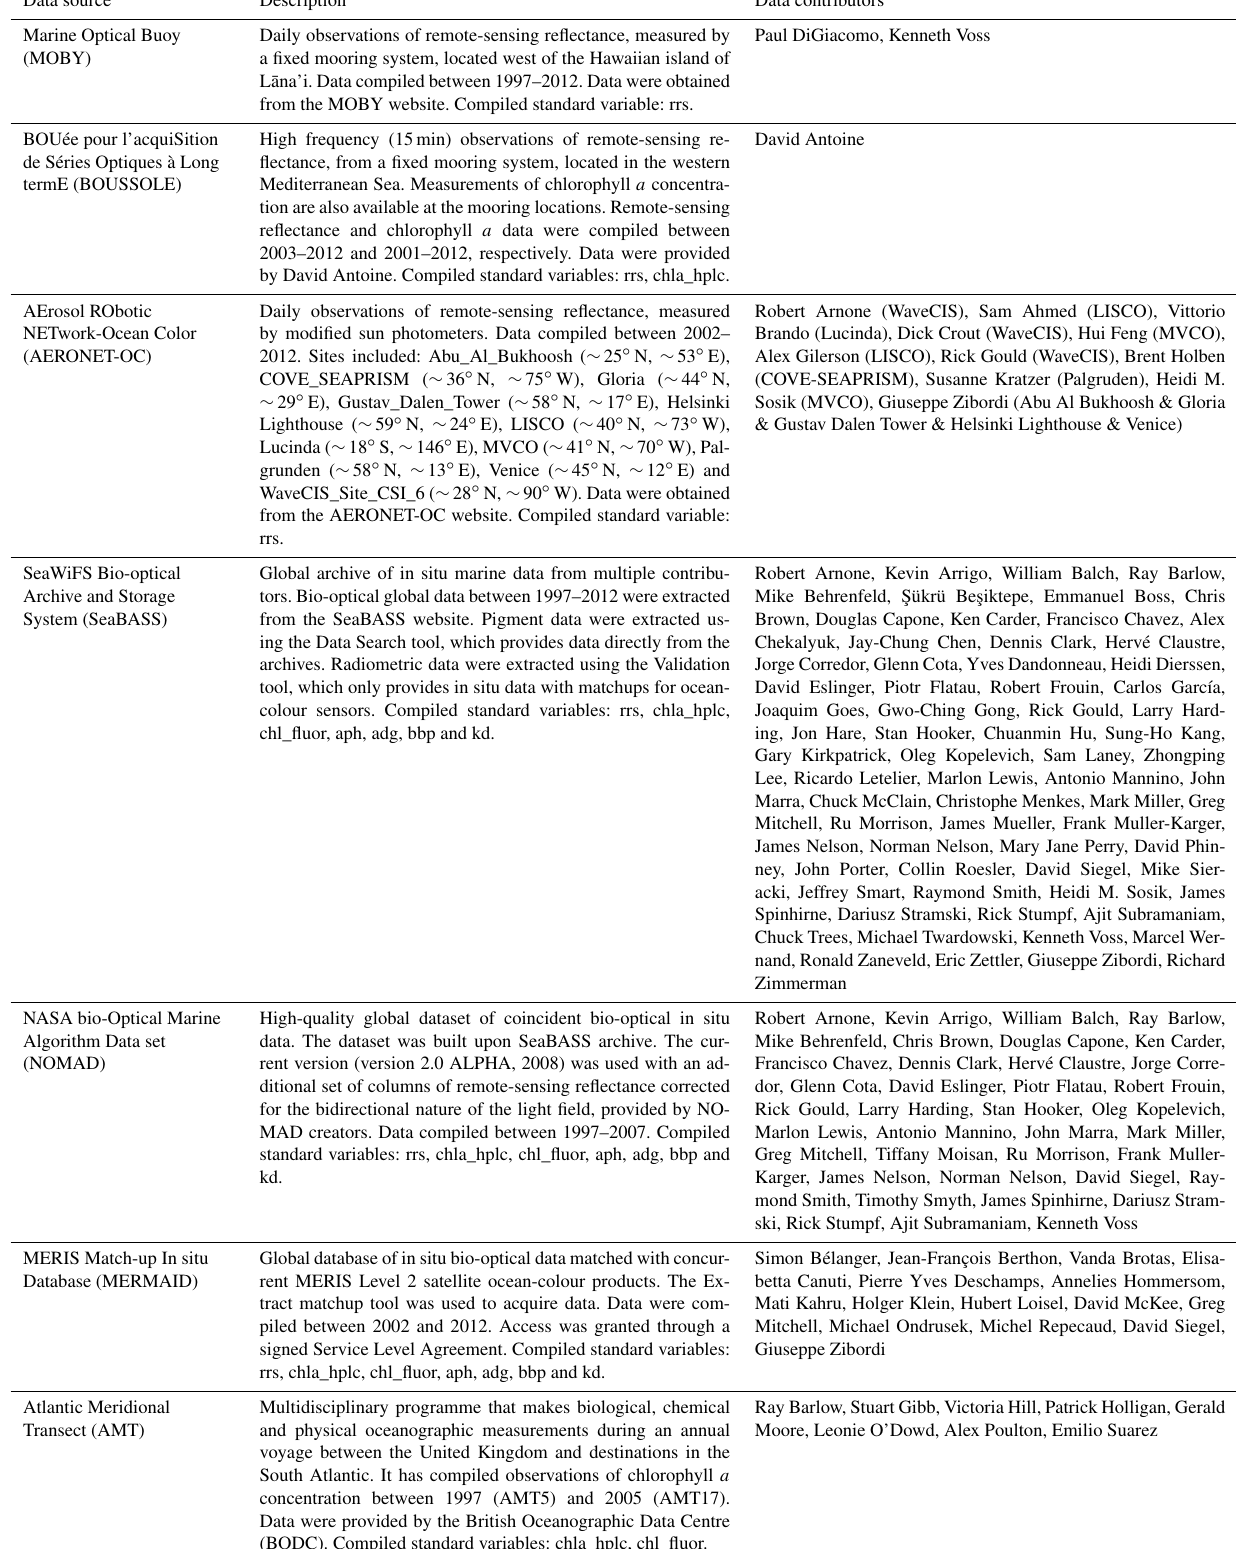
Table 2. Original sets of data and data contributors in the final table. Data